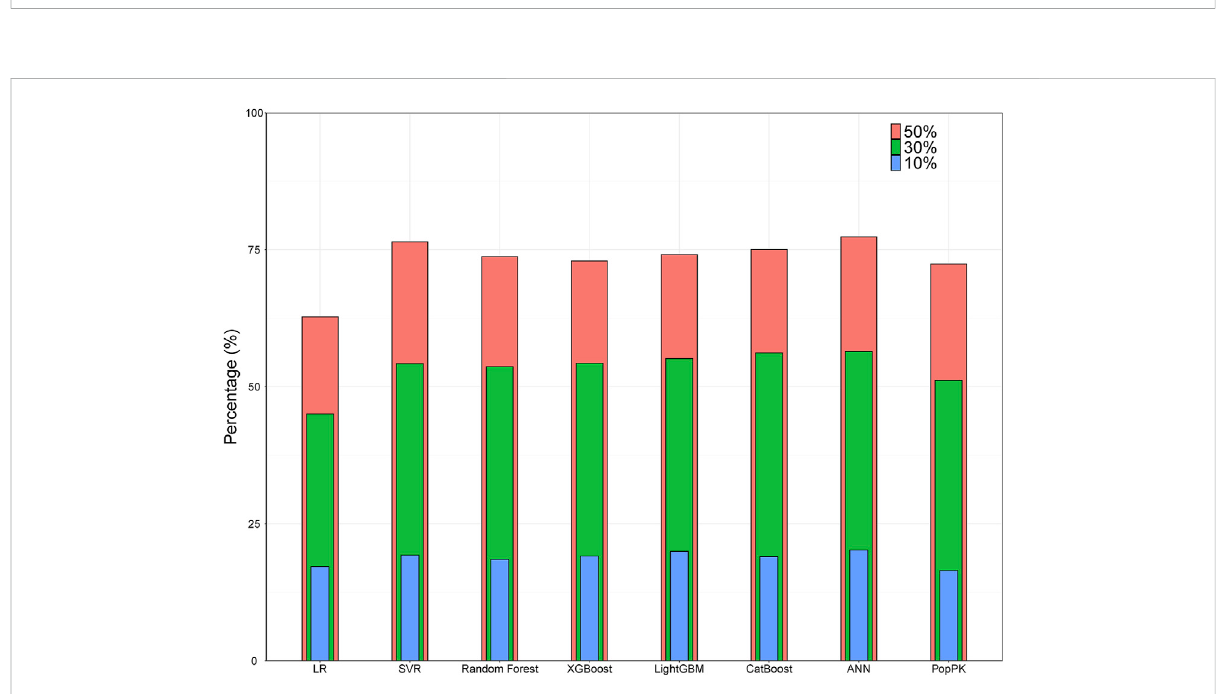
FIGURE 3 Bar plot showing the percentages of prediction error within 10%, 30%, and 50% for ML and popPK models. ANN, arti fi cial neural network; ML, machine learning; popPK, population pharmacokinetic model; LR, linear regression; SVR, support vector